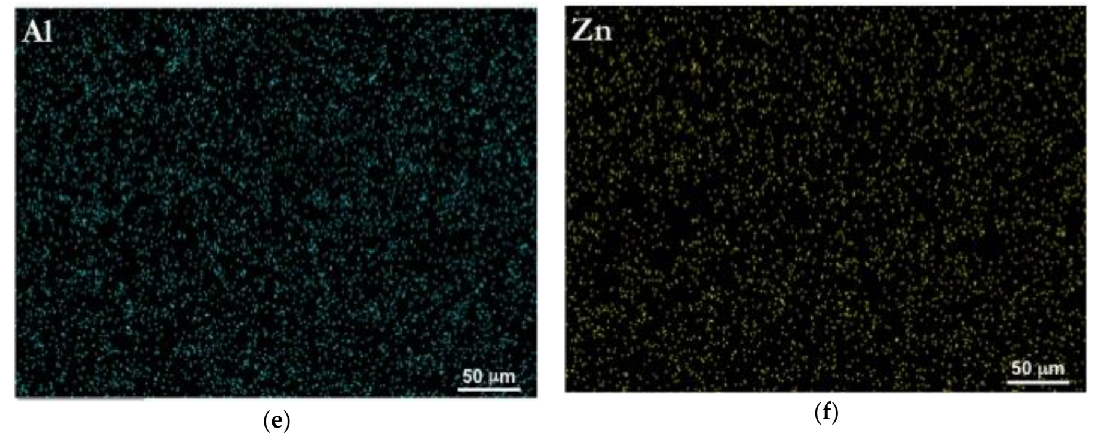
Figure 3. ( a ) SEM micrograph of TXAZ3200 alloy and its corresponding energy-dispersive spectroscopy